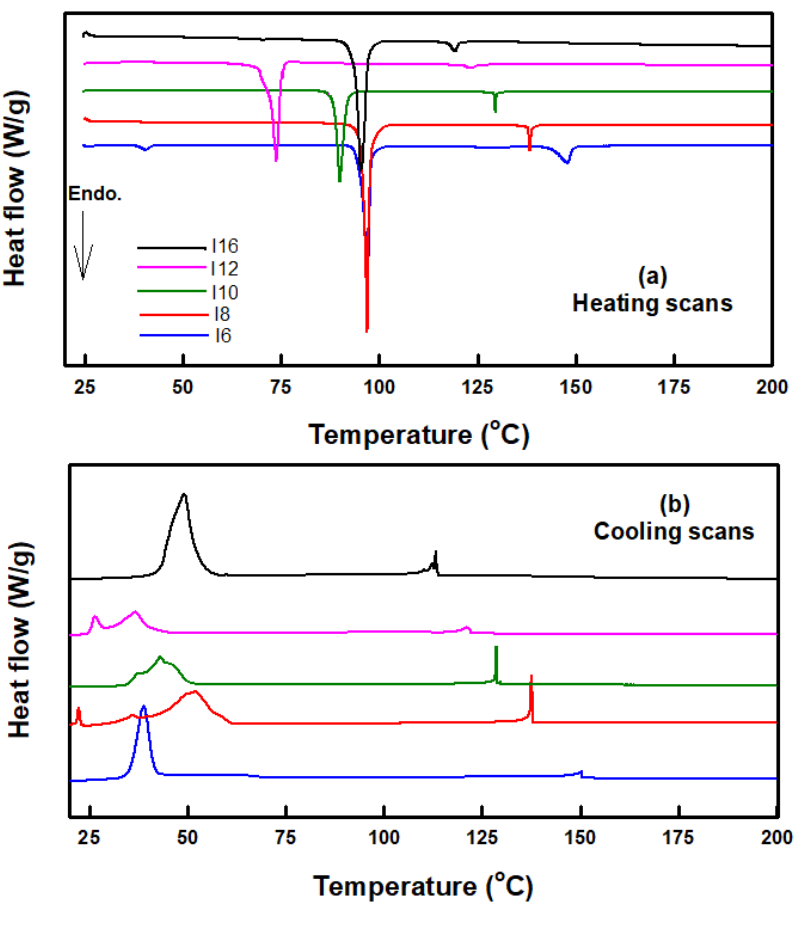
Figure 2. The recorded DSC thermograms of series I n at a rate of ± 10 °C/min ( a ) the second heating and ( b ) cooling scans.